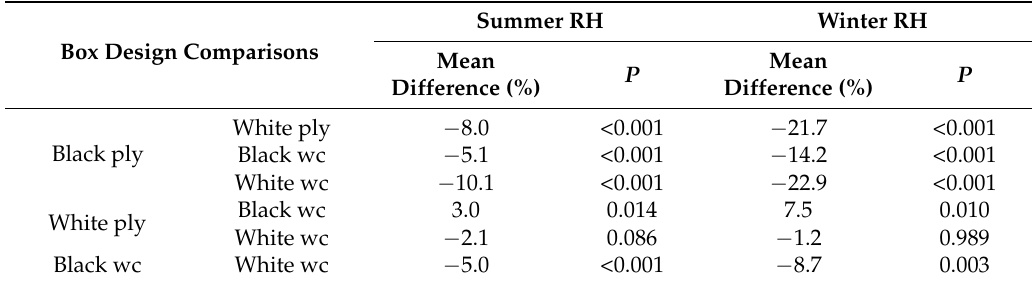
Table 6. Pairwise comparison of box designs in front chambers for ‘warmest day period’ RH over the 5-day period for summer and winter. ply = plywood; wc =